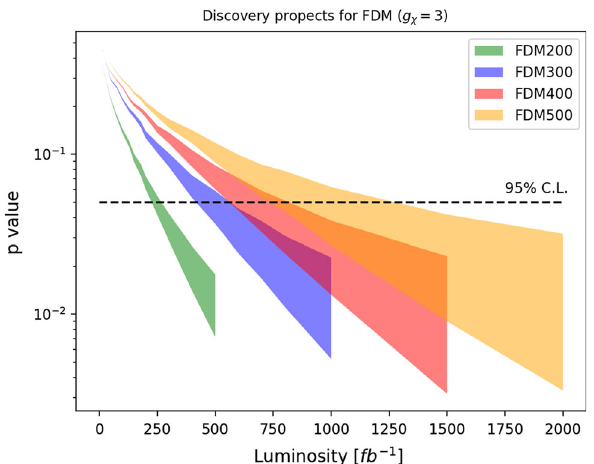
Fig. 6 DiscoveryprospectsofbenchmarkpointsinFDMmodelat100 TeV pp collider. The widths of bands are showing the sensitivitieswith- out systematic uncertainty (lower boundary) and assuming systematic uncertainty of 1% (upper boundary). The p value correspond to 95% C.L. probing is indicated by the horizontal dashed